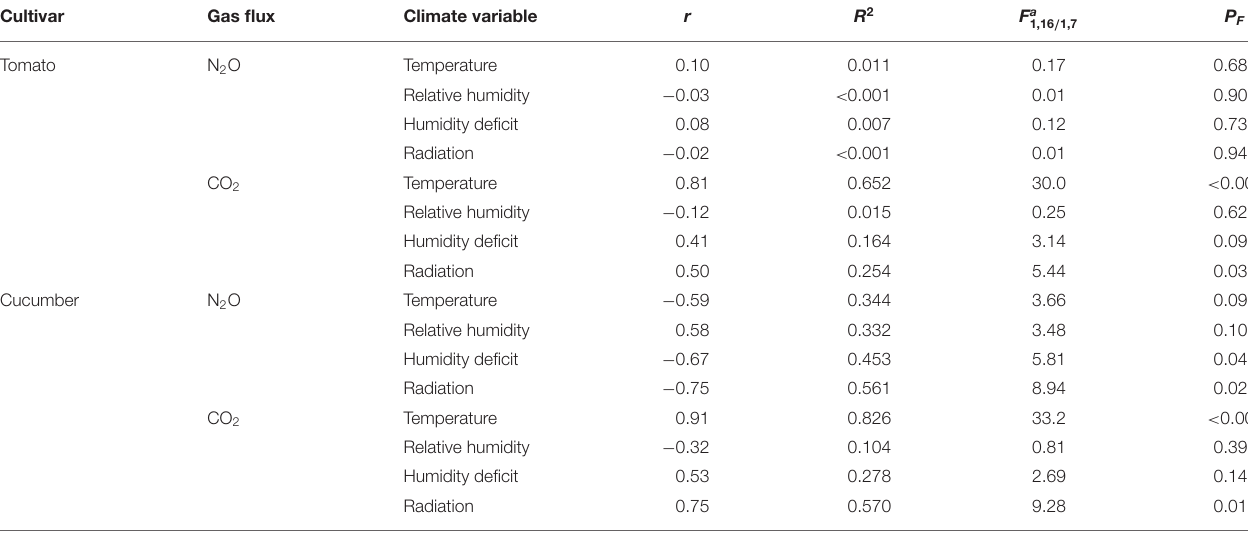
TABLE 2 | Results of linear regression analyses between average N 2 O or CO 2 emission rates (without time points at the end of the growing season when no nutrient solution was applied) and greenhouse climate variables at the corresponding sampling dates in 2019.